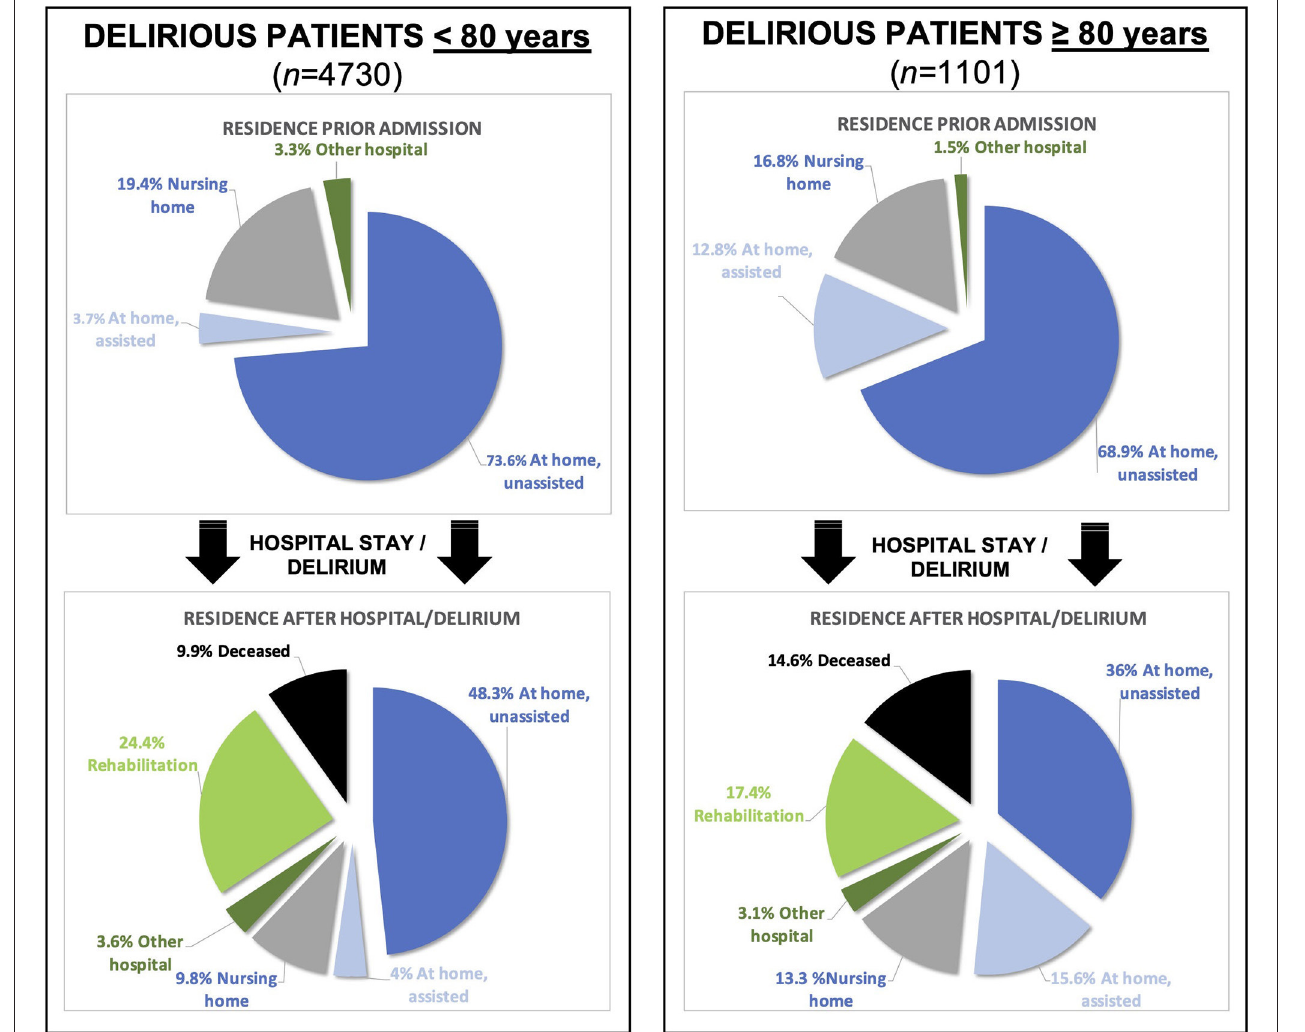
FIGURE 2 | Graphical illustration (pie chart) of the residence before and after the hospital stay/delirium of the two groups. Note that delirious patients ≥ 80 years have a higher mortality and lose more often their